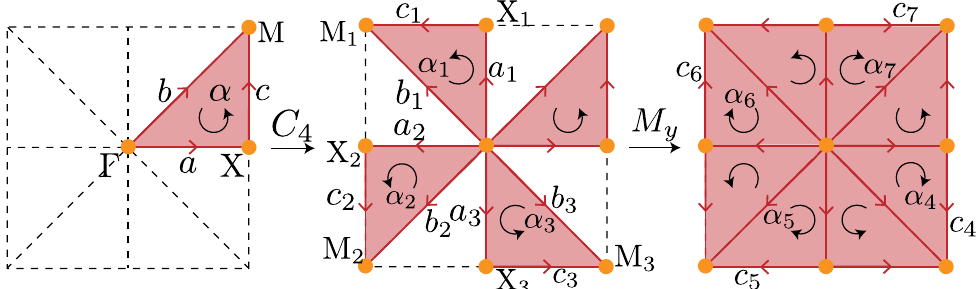
FIG. 5. Cell decomposition for p 4 mm . We first find a unit of BZ illustrated in the left. The red and black arrows signify orientations of 1-cells and 2-cells, respectively. Then, we rotate each p -cell in the unit by fourfold rotation symmetry. Finally, mapping them by the mirror symmetry, we arrive at the cell decomposition shown in the right.